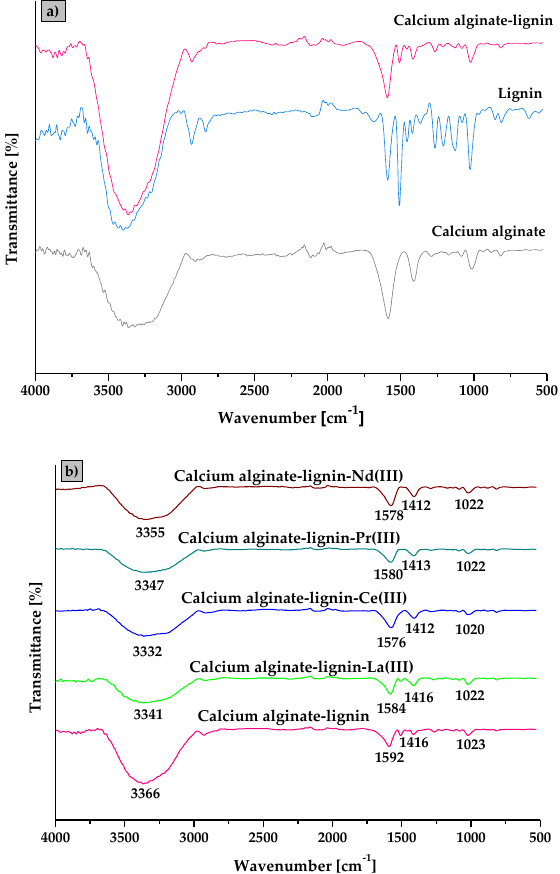
Figure 1. ATR/FT-IR of ( a ) calcium alginate, lignin, calcium alginate lignin composite and ( b ) before and after the La(III), Ce(III), Pr(III), and Nd(III) ions sorption on the calcium alginate – lignin composite.